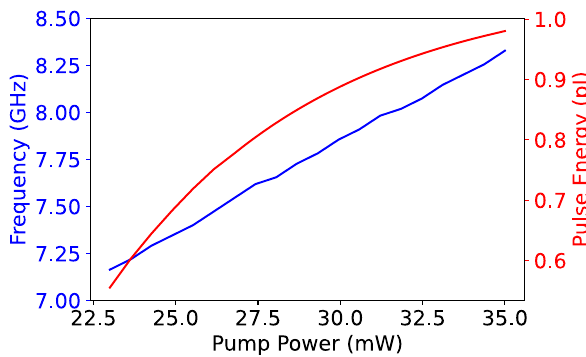
Figure 7: The pulsation frequency and pulse energy as the pump = 0.6 eV and Γ = 10 power is varied. E f